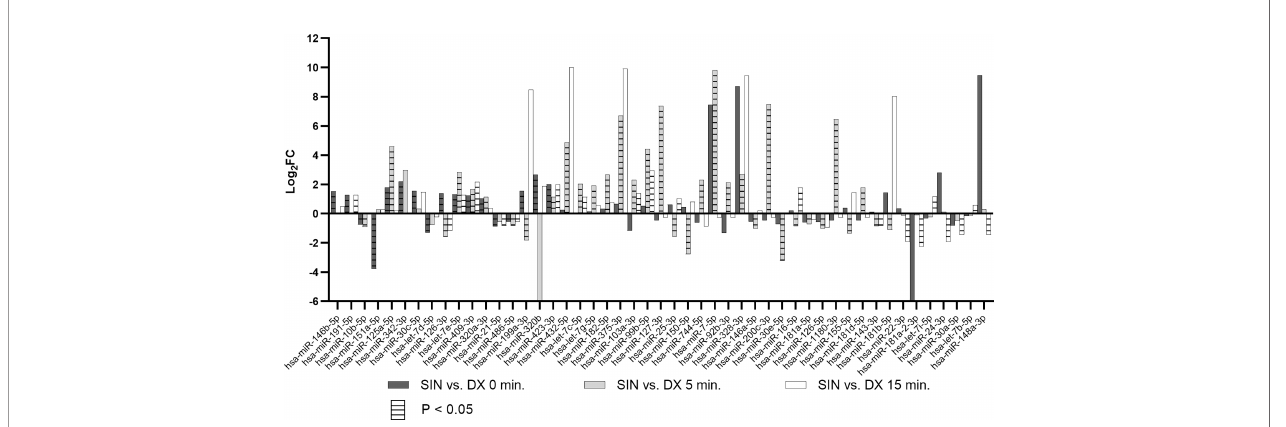
FIGURE 5 | Differentially expressed miRNAs in BIPSS samples across all three time points. The bar chart represents Log2FCs of all differentially expressed miRNAs with Bonferroni P < 0.05. Bars without horizontal lines represent fold changes of adjacent time points (0, 5, 15) but are not statistically signi fi cant (Bonferroni P > 0.05). DX - dextral side, SIN - sinistral